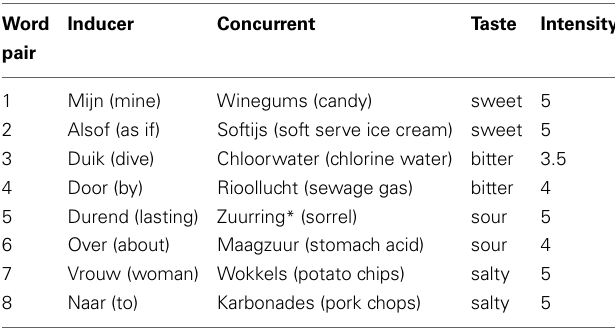
Table 1 | Stimuli used in the behavioral priming